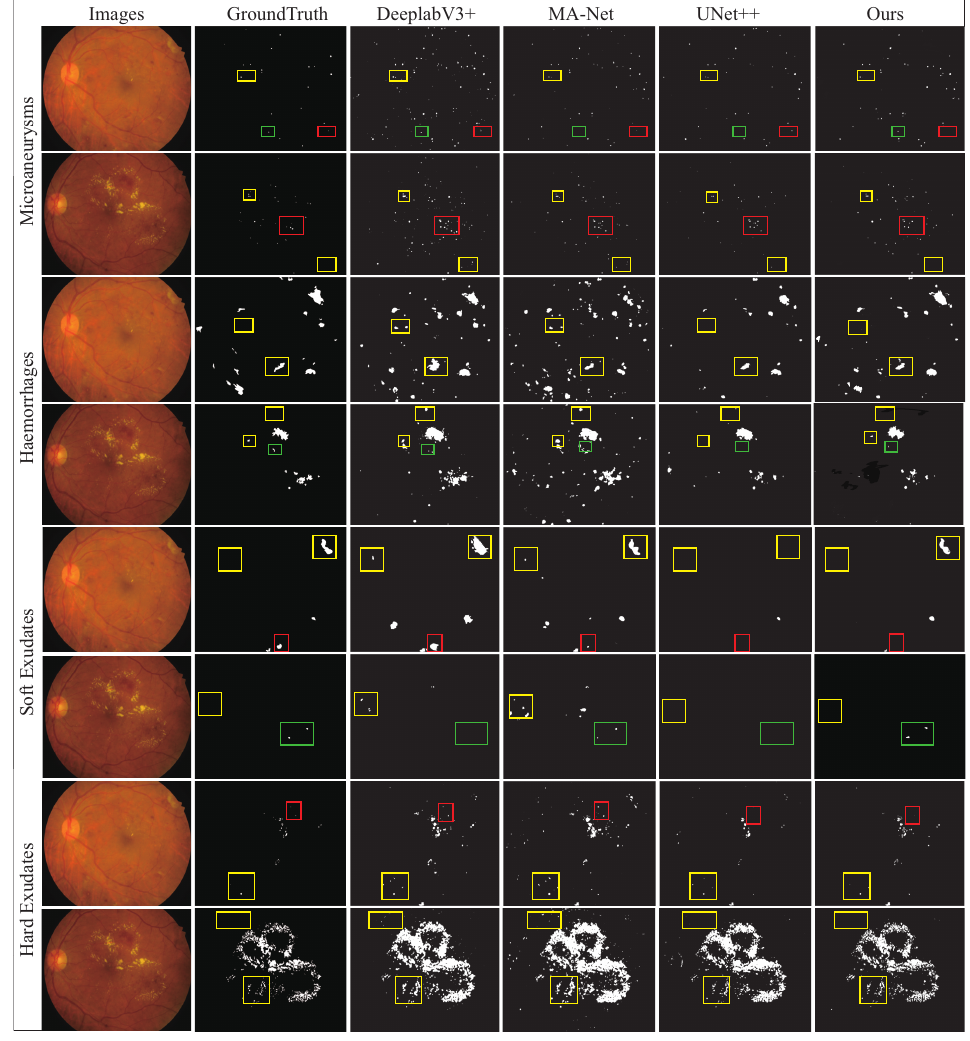
Figure 10. Illustration of fundus image with DR